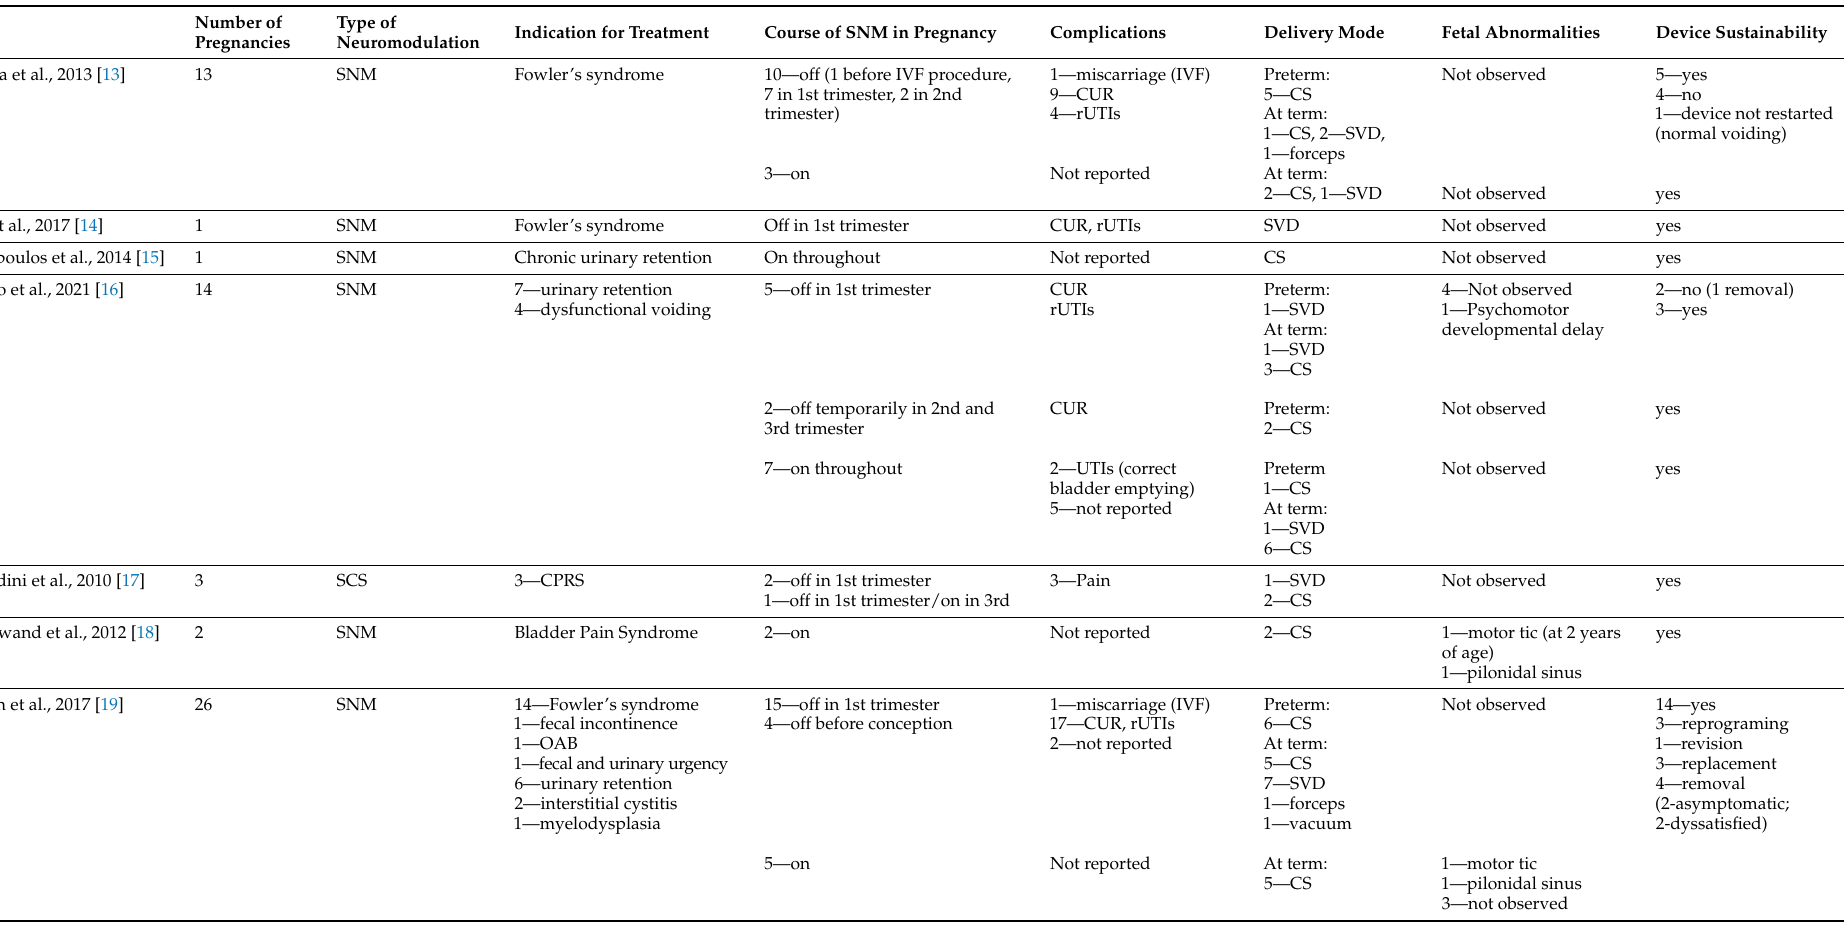
Table 1. Summary of the included studies. SNM—sacral neuromodulation, SCS—spinal cord stimulation, CPRS—complex regional pain syndrome, OAB—overactive bladder, CUR—chronic urinary retention, rUTIs—recurrent urinary tract infections, IVF—in vitro fertilization, CS—cesarean section, SVD—spontaneous vaginal